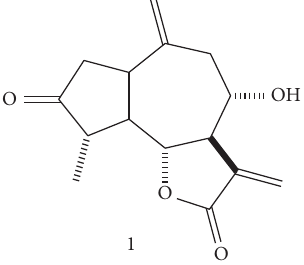
Figure 1: Chemical structure of